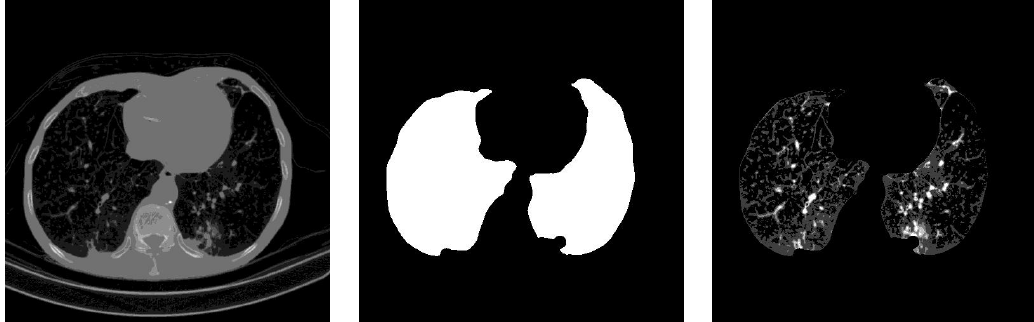
Figure 12. Segmented lung lobes of infected slices with COVID-19 and Cap. Rows 1, 2, and 3 are for COVID-19, Cap, and Cap slices, respectively.